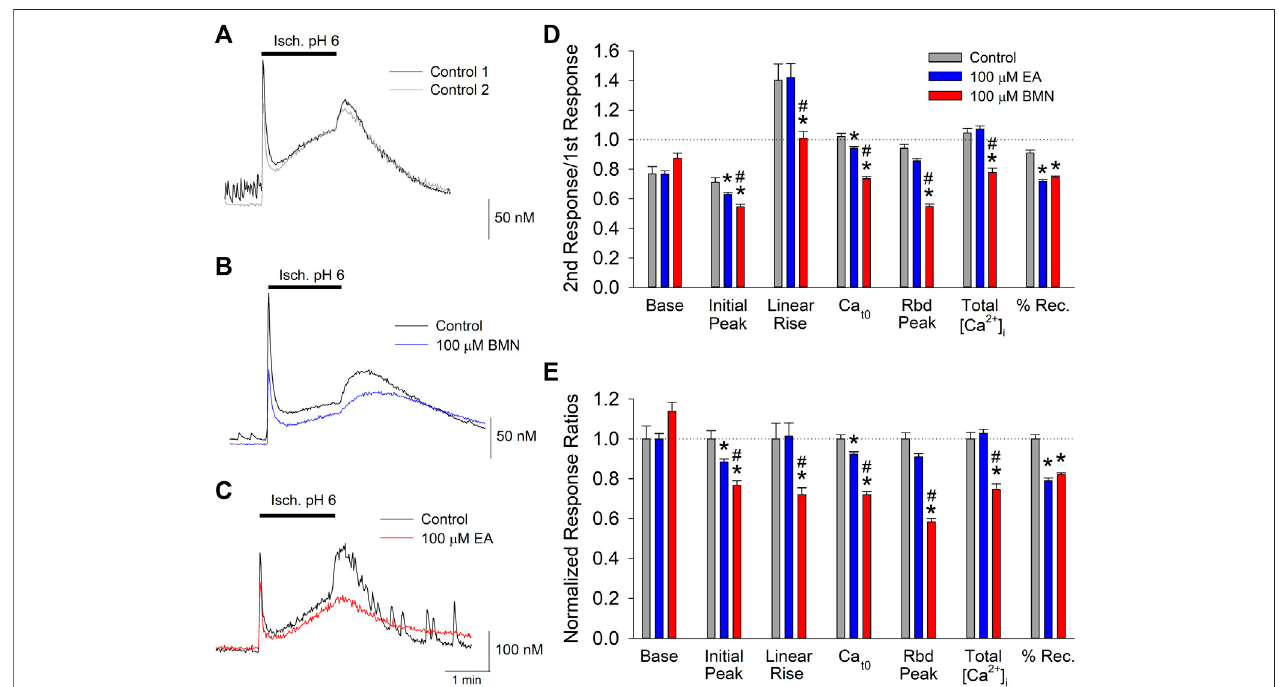
FIGURE1| Ischemia-acidosisevoked[Ca 2+ ] i increasesinculturedratcorticalneuronsareinhibitedbybumetanideandethacrynicacid.A,Representativetracesof [Ca 2+ ] i as a function of time recorded from a single neuron in response to an initial 2-min ischemia-acidosis insult (Isc. pH 6; Control 1, black trace) and a second applicationoftheIsc.pH6solutionfollowinga20-minrecoveryperiod(Control2,graytrace).Representativetracesof[Ca 2+ ] i recordedfromtwoneuronsusingthesame protocolasin (A) ,intheabsenceandpresenceof100 μ Mbumetanide[ (B) ;Control,blacktrace;100 μ MBMN,bluetrace]or100 μ Methacrynicacid[ (C) ;Control, black trace, 100 μ M EA, red trace]. (D) , Relative mean [Ca 2+ ] i ( ± SEM) responses obtained using the paired protocol with the second response, in the absence (Control, n (cid:1) 59)andpresenceof100 μ Mbumetanide(BMN, n (cid:1) 156)or100 μ MEthacrynicAcid(EA, n (cid:1) 140),normalized tothe fi rstcontrolresponse.Peak[Ca 2+ ] i increasewas measuredimmediatelyafterapplicationoftheischemia-acidosissolution.Sustained[Ca 2+ ] i wasmeasuredjustpriortowashoutoftheIsc.pH6solution.Rebound[Ca 2+ ] i wasthemaximum [Ca 2+ ] i measured following washoutof Isc.pH 6solution. Thepercent recovery (%Rec) wascalculated asthe fi nal [Ca 2+ ] i normalized tothe maximum [Ca 2+ ] i aftertheinitialtransientpeak([ fi nal-baseline]/[reboundpeak-baseline]).Total[Ca 2+ ] i increaseswerecalculatedbyintegratingbeneaththetracesof[Ca 2+ ] i vs.time. (E) , Same data in (D) with ratios normalized to Control/Control ratios. Asterisks denote signi fi cant difference from Control ( p < 0.05) and pound symbols indicate signi fi cant difference between BMN and EA ( p < 0.05). Bars above (A) , (B) and (C) indicate duration of ischemia-acidosis (Isc. pH